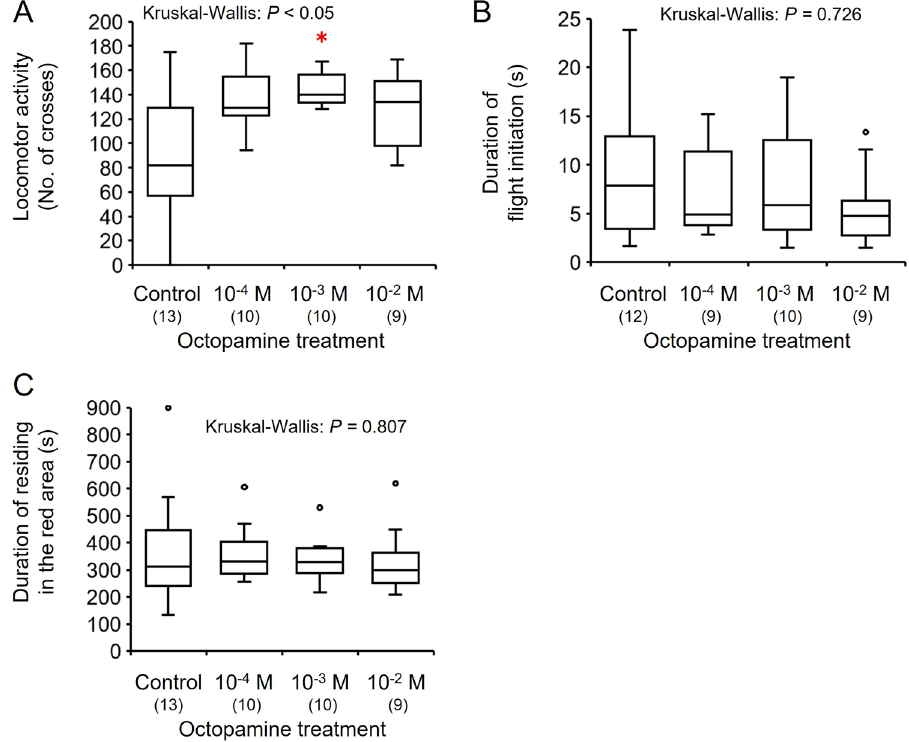
Figure 5. Effects of octopamine injection on behavioral activities of 4-day-old males in the bumble bee: ( A ) spontaneous locomotor activity, ( B ) duration of flight initiation, ( C ) duration of time residing in the red area as a light preference index. Locomotor activity, duration of initiation, and duration of residing in the red area are indicated by box plots. A significant difference according to the Steel test ( P < 0.05) is indicated by an asterisk. Sample sizes are shown in